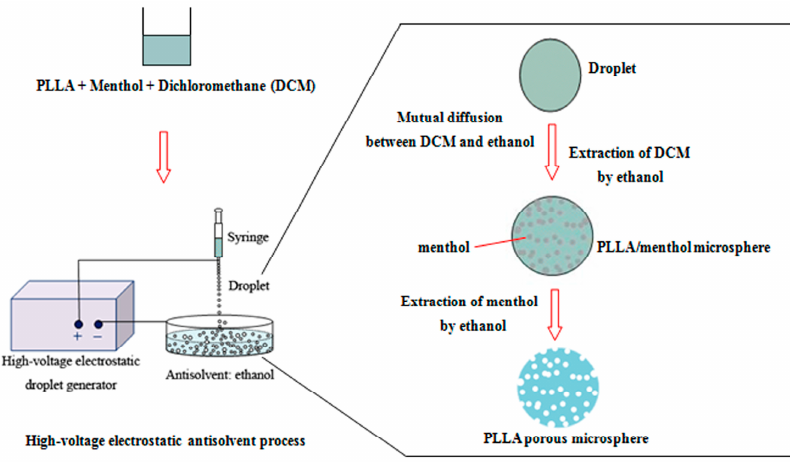
Figure 1. Schematic description of preparation of PLLA PMs.